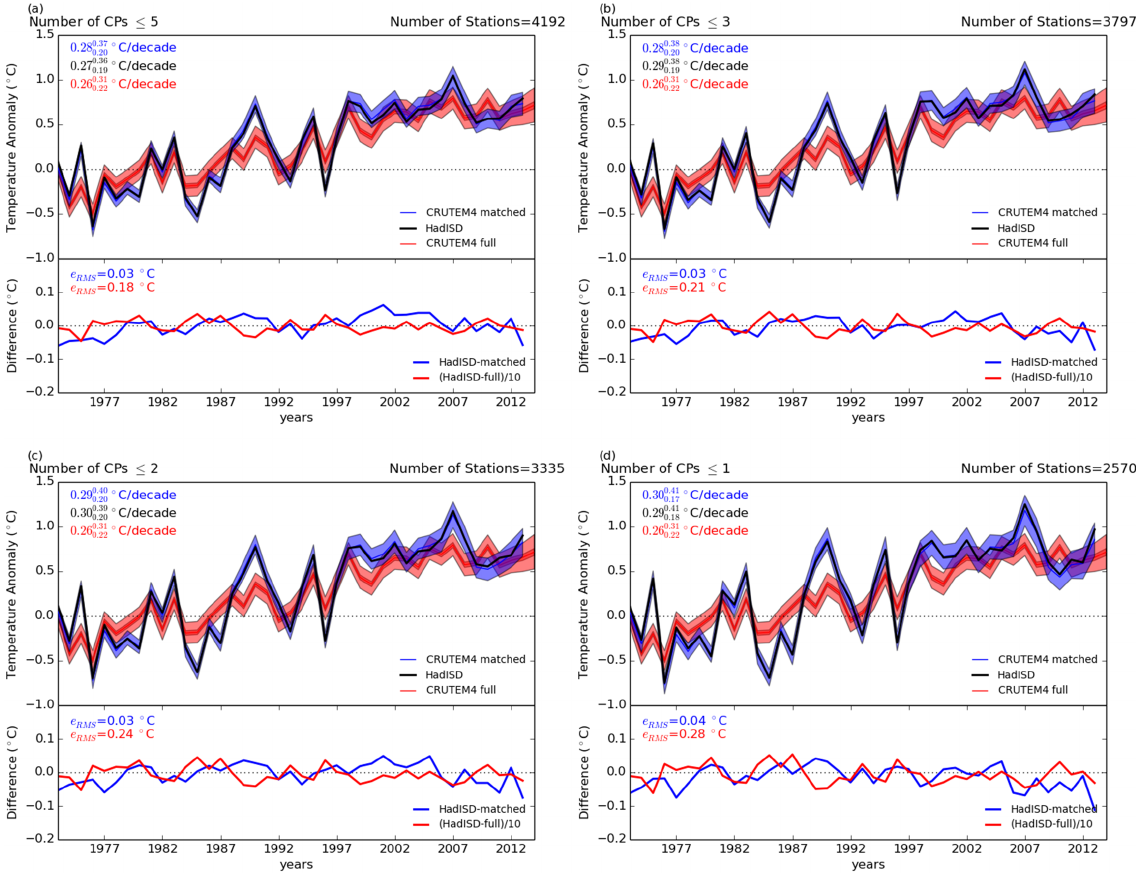
Figure 17. As for Fig. 15 but for stations with inhomogeneity magnitudes < 1 ◦ C. (a) No more than five, (b) three, (c) two and (d) one inhomogeneity allowed in the full record of the